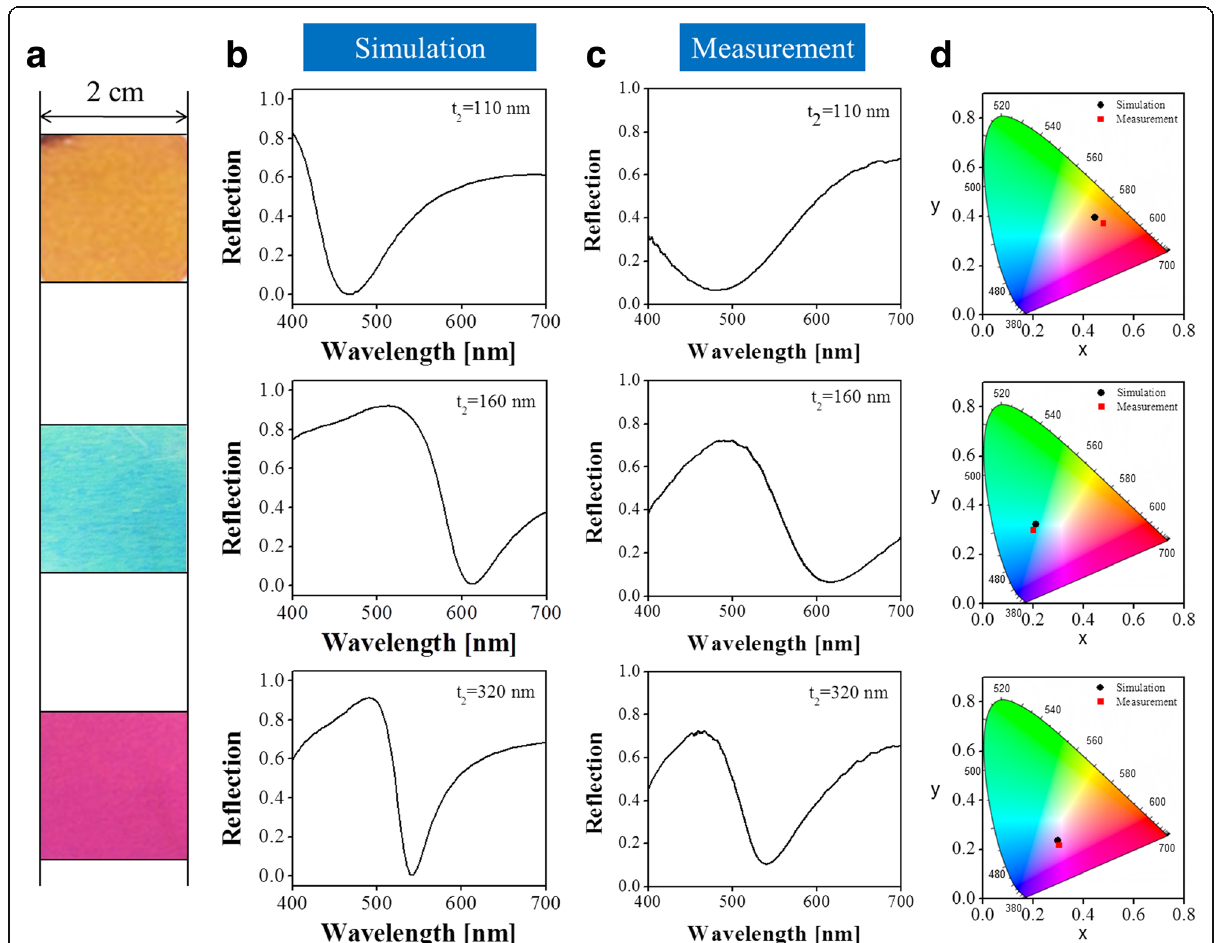
Fig. 5 a Captured optical color images at normal incidence from the manufactured devices with different NAA thicknesses of t 2 = 110, 160, and 320 nm. b Simulated and ( c ) measured reflection spectra of the fabricated devices. d Corresponding chromaticity coordinates in the CIE 1931 chromaticity diagram in response to the simulated and measured